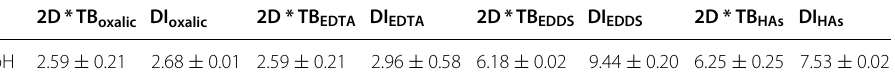
Table 2 pH values for brines with chelating agents (2D * TB chelating ) and deionized water with chelating ( DI chelating